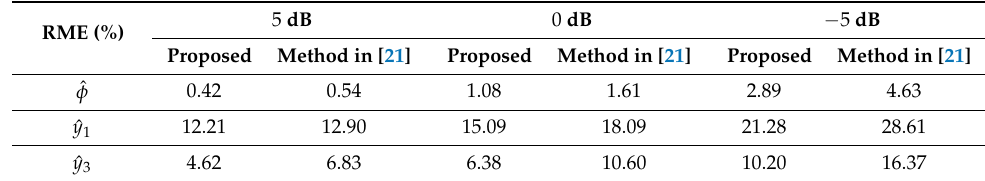
Table 3. Reconstruction performance